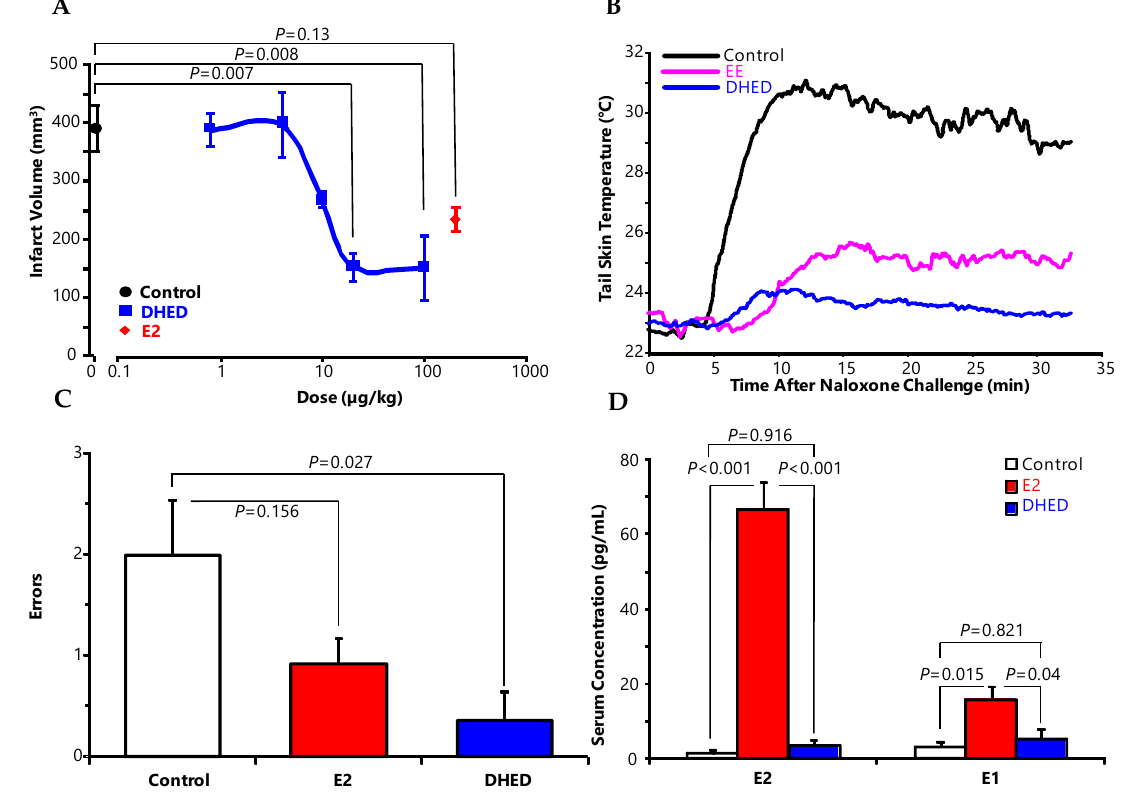
Figure 6. DHED treatment elicits profound neuropharmacological e ff ects without increasing circulating estrogen levels. ( A ) Dose-dependent brain lesion volumes in ovariectomized (OVX) rats treated with DHED 1 h before tMCAO followed by 24-h reperfusion. The control groups received 200 µ g / kg, s.c., E2 or vehicle alone. One-way ANOVA yielded a main e ff ect of treatment (F (6,14) = 8.76, p < 0.001). Data are average ± SEM, n = 3. Similarly to the rats treated with E2, statistical analyses revealed significant di ff erences infarct volume of vehicle-treated animals, when rats received 20 and 100 µ g / kg of DHED. ( B ) Tail-skin temperature changes in an OVX rat hot flush model after oral administrations of DHED, EE used as positive control, and the vehicle control. ( C ) In the delay match-to-sample plus maze test, E2- and DHED-treated middle-aged OVX Fisher-344 rats (continuously for 48 days by s.c. Alzet osmotic minipumps delivering 4 µ g daily dose, respectively) made fewer errors compared to the vehicle-treated control group. One-way ANOVA: F(2,12) = 4.73, p = 0.031, n = 5 per treatment group. ( D ) Serum E2 and E1 concentrations of treatment groups from Panel C . Data are average ± SEM, n = 5. All displayed P values were determined by ANOVA followed by post hoc Student-Newman-Keuls multiple comparison tests, and p < 0.05 was considered statistically significant. Reproduced with permission from reference [36]; copyright American Association for the Advancement of Science.